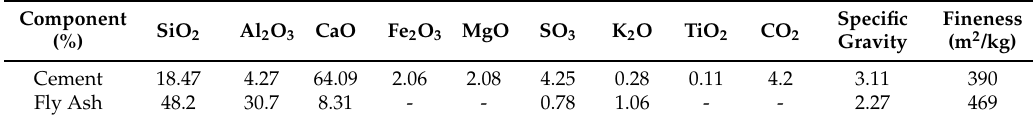
Table 3. Chemical composition and physical